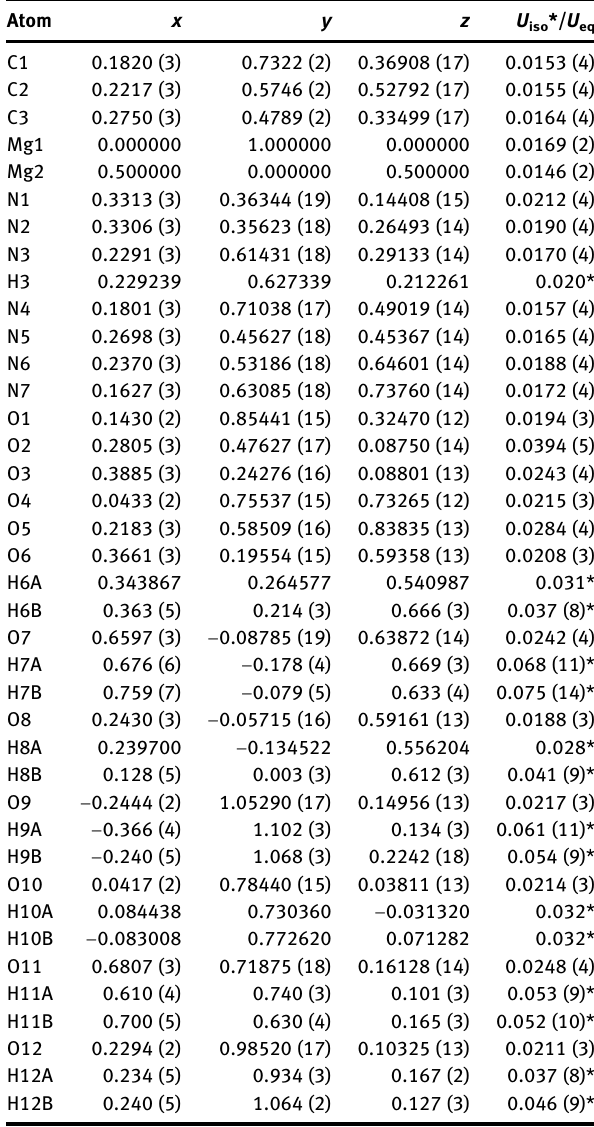
Table  : Fractional atomic coordinates and isotropic or equivalent isotropic displacement parameters (Å  ).